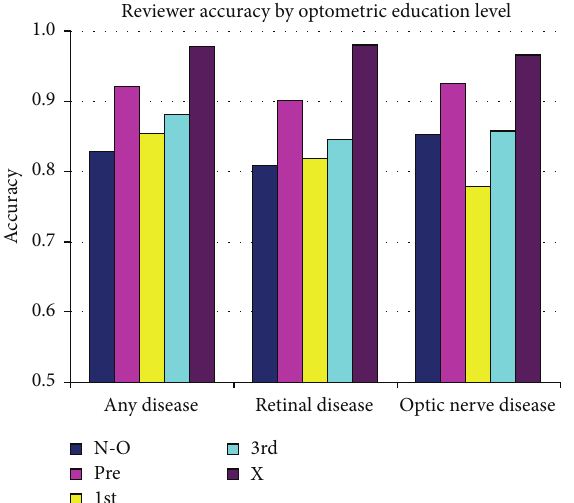
Figure 7: Reviewer accuracy by clinical exposure level.